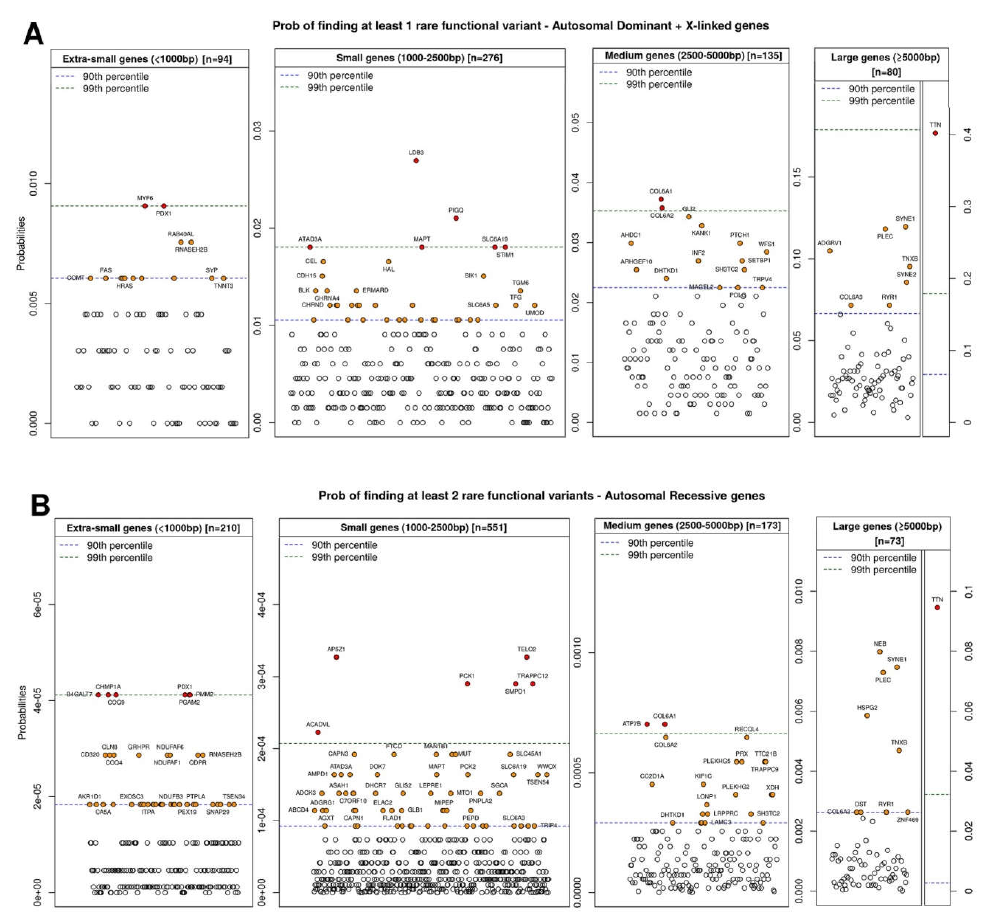
Figure 3. ( A ) Probability of finding at least one rare functional variant (all but synonymous, GMAF < 0.5%) in autosomal dominant and X-linked genes, grouped by gene length: extra-small genes (<1000 bp), small genes (1000–2500 bp), medium genes (2500–5000 bp), and large genes (>5000 bp). ( B ) Probability of finding at least two rare functional variants (all but synonymous, GMAF < 0.5%) in autosomal recessive genes, grouped by gene length.